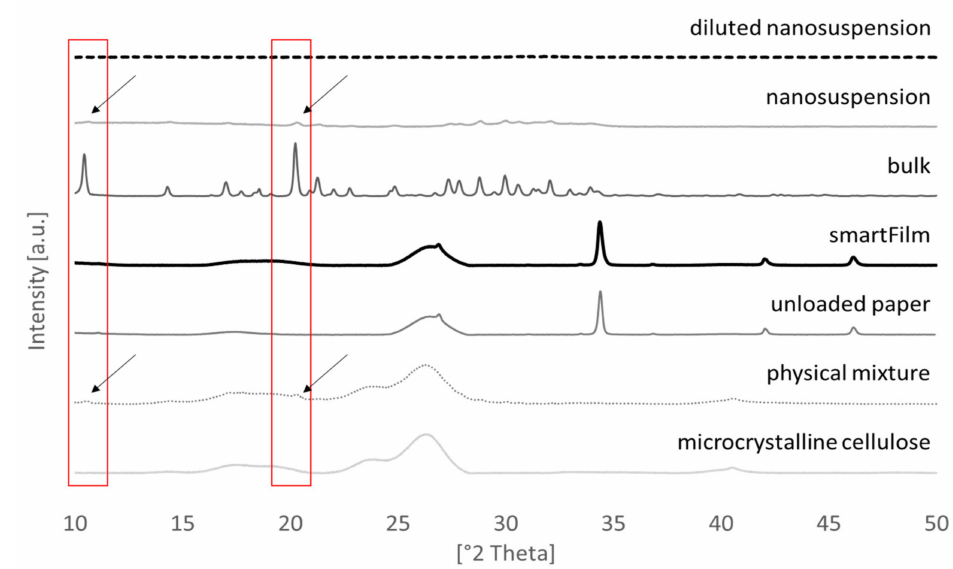
Figure 2. Results from XRD analysis. Table 1. Overview of results obtained from the physicochemical characterization of curcumin-loaded smartFilms, bulk- and